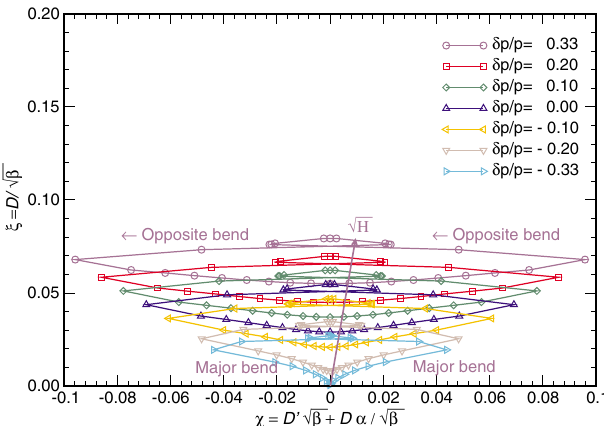
FIG. 10. (Color) Normalized dispersion function during accel- eration for different momenta.